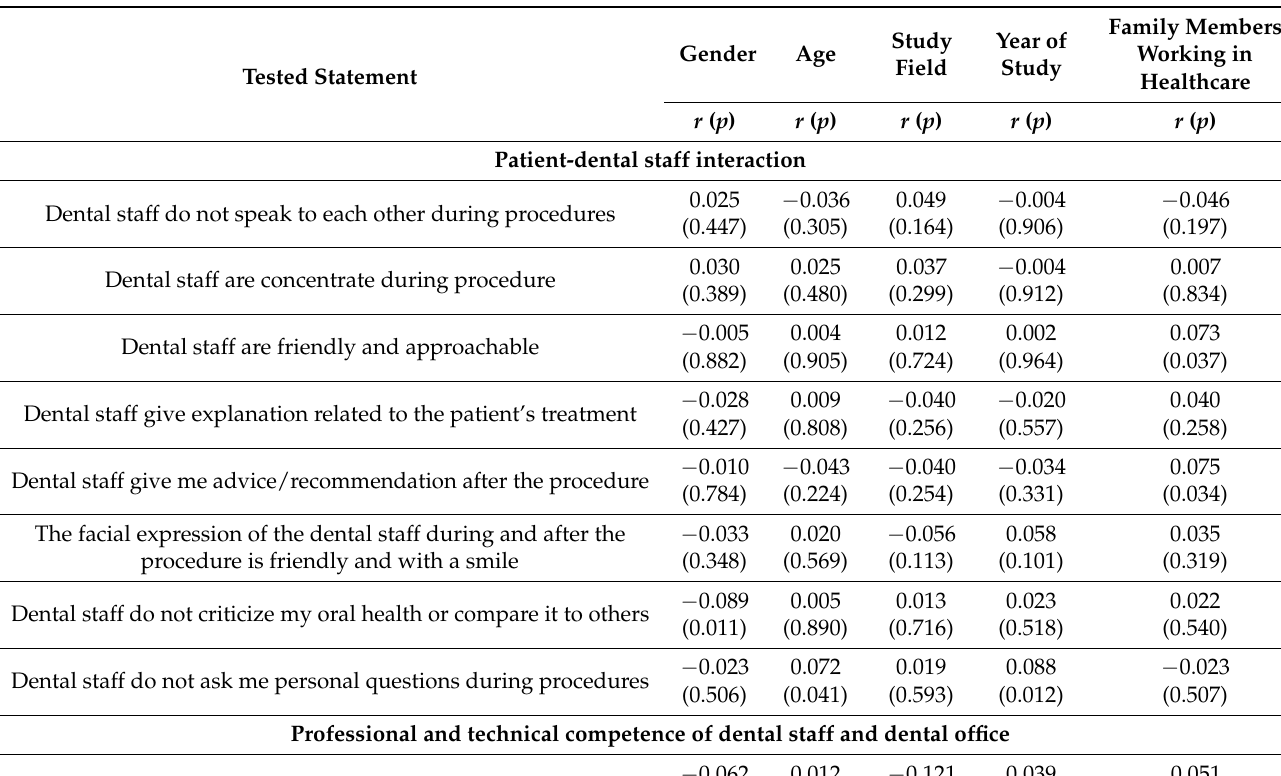
Table 4. Correlation between respondents’ attitudes related to satisfaction with the dental service provided in primary healthcare and their sociodemographic